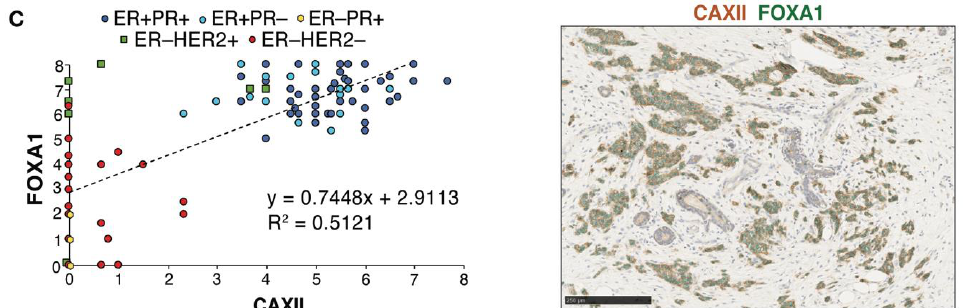
Figure 6. Protein expression levels of CAXII and of the luminal transcription factors ER α , FOXA1 and GATA3 are correlated in breast tumors. Correlations between CAXII and ER α ( A ), GATA3 ( B ) or FOXA1 ( C ) expression scores are shown for all tumors in the TMAs. Scores were computed by QuPath using membrane (CAXII) and nuclear signal intensities (ER α , GATA3, FOXA1). ER + PR + tumors are highlighted in dark blue circles, ER + PR − tumors in light blue circles, ER − PR + tumors in yellow diamonds, ER − HER2 + tumors in green squares and ER − HER2 − tumors in red circles. Representative co-staining for CAXII (brown) and each of these luminal transcription factors (green) is also shown.